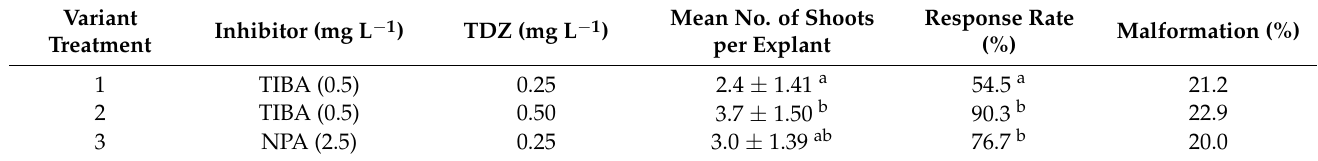
Table 5. Effect of different treatment variants (inhibitors and TDZ concentration) on shoot regenera- tion and malformation rate (%) of initial explants of C. sativa var.